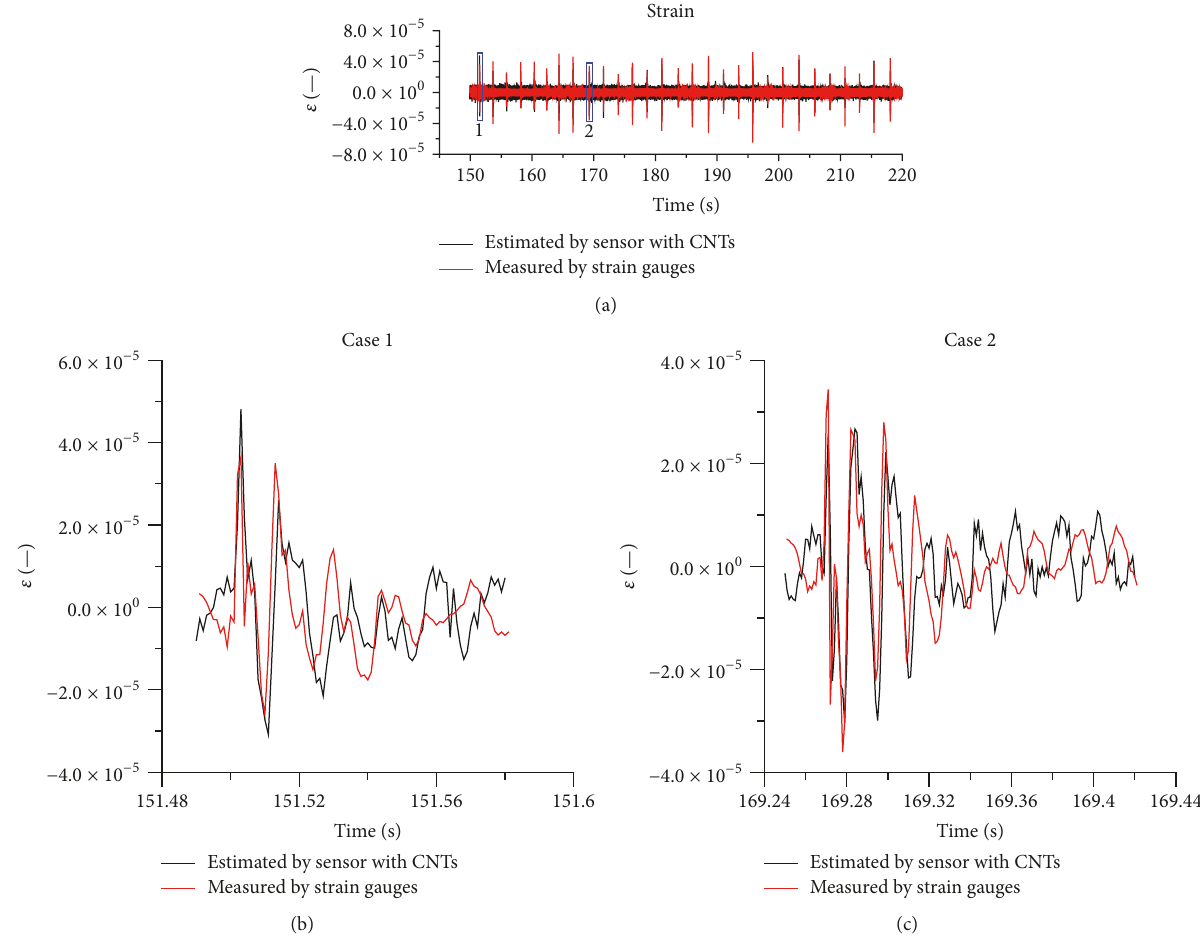
Figure 13: Time histories of measured average strain from strain gauges and estimated strain from electrical measurements (a); enlarged view of measurements number 1 (b) and number 2